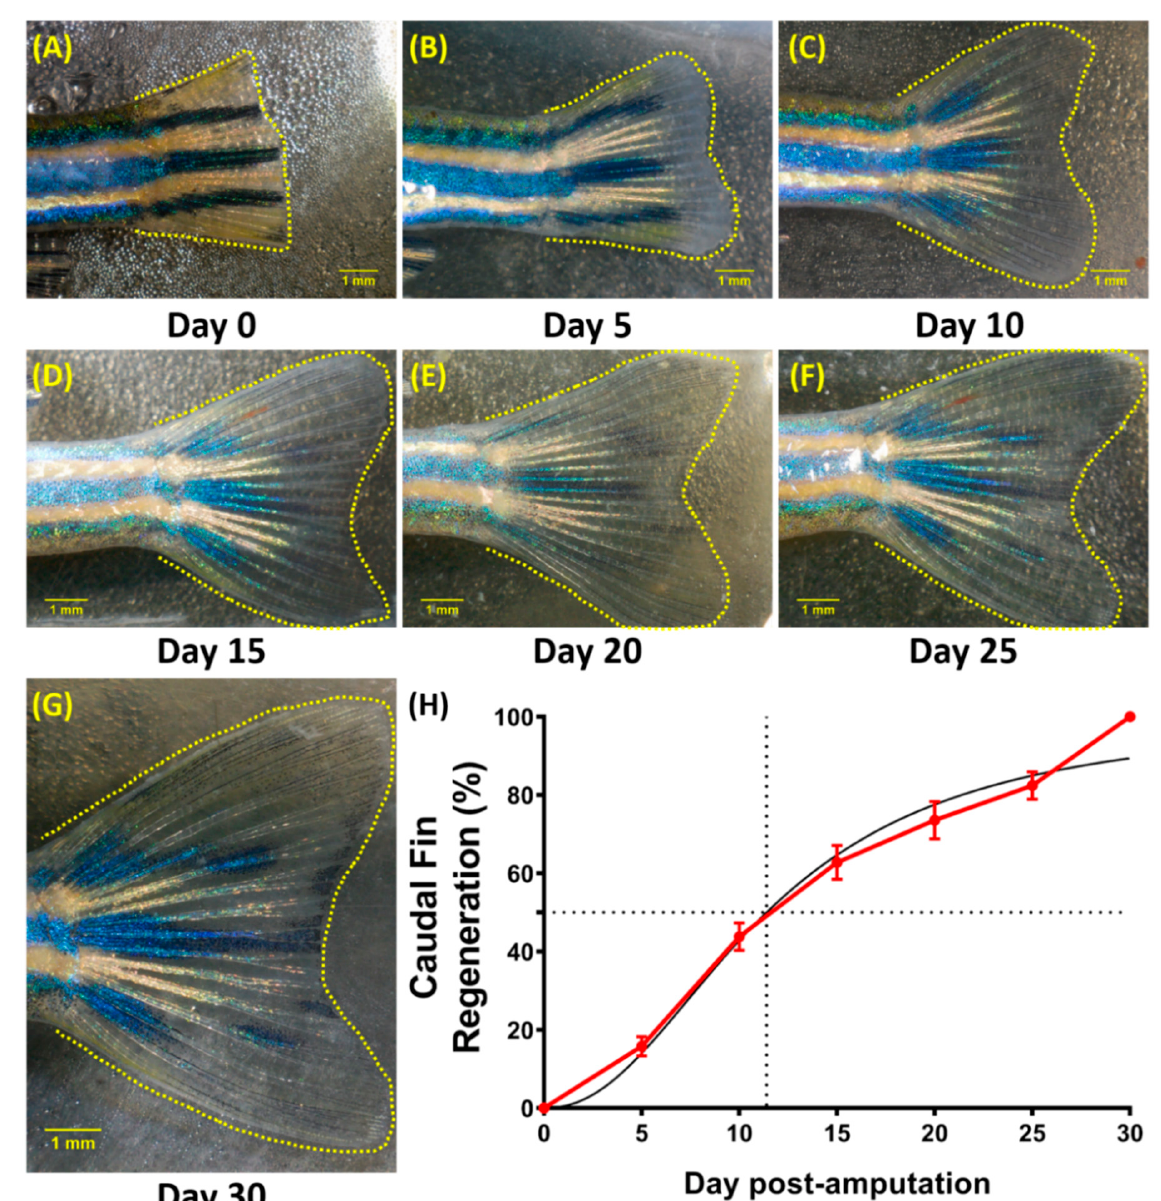
Figure 5. Representative images of a caudal fin regeneration from a single fish at ( A ) 0, ( B ) 5, ( C ) 10, ( D ) 15 ( E ) 20 ( F ) 25, and ( G ) 30 days post-amputation. ( H ) Caudal fin regeneration curve during 30-day observation (red line) with the mathematical model of regeneration percentage prediction (normalized) (black line), which indicates that 50% of regeneration occurred approximately 11 days after the amputation. The data are expressed as the mean with SEM ( n = 18).